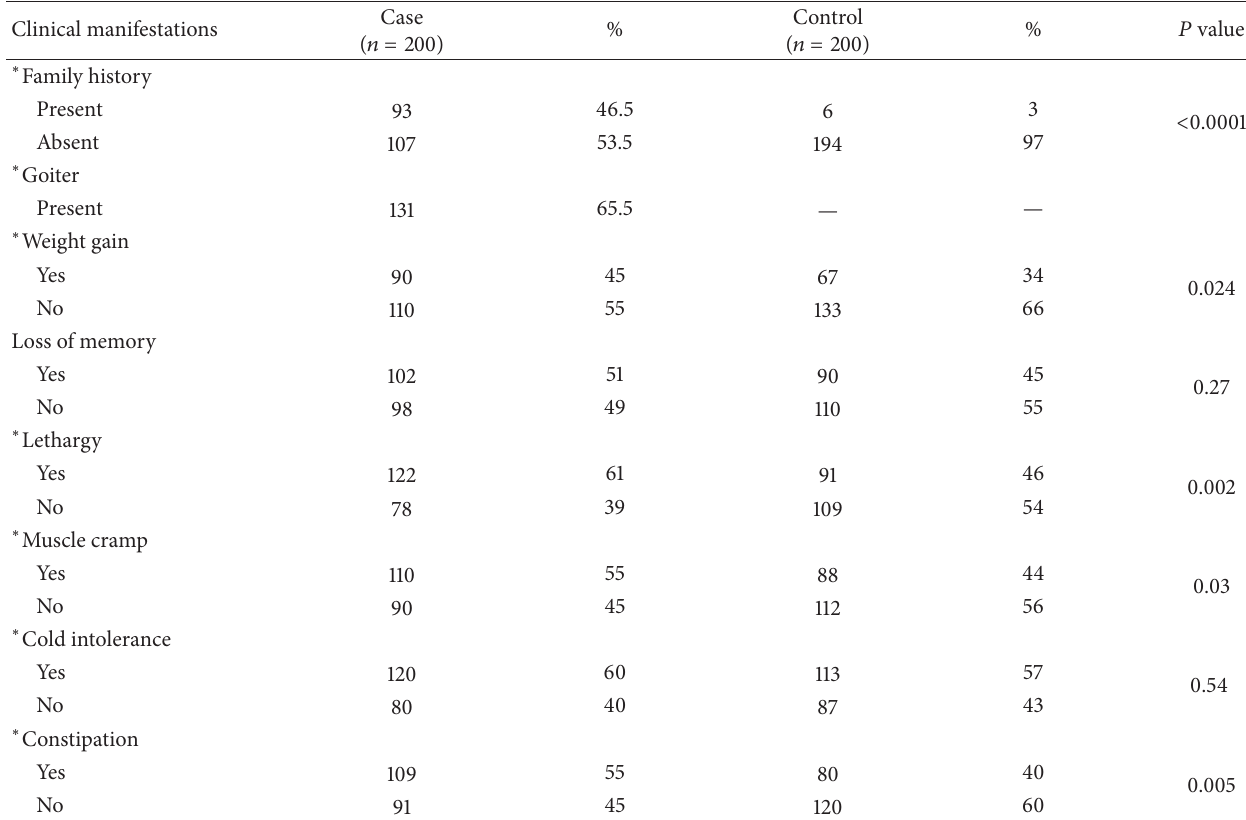
Table 3: Clinical manifestations of case at initial